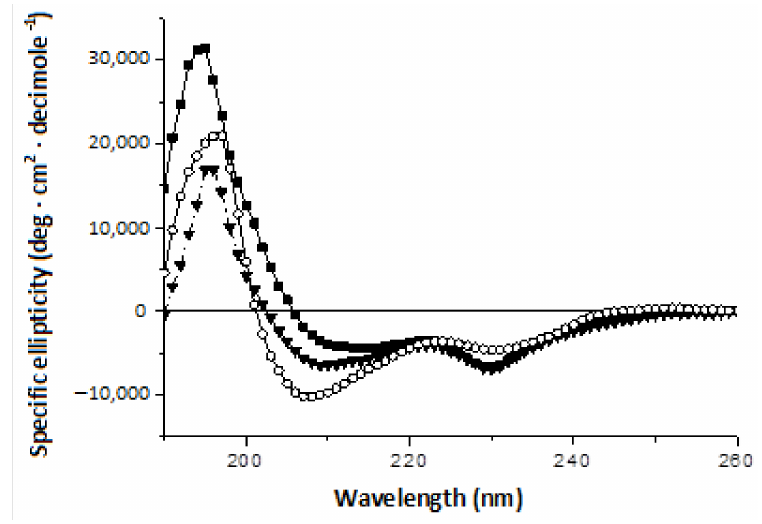
Figure 2. Circular dichroism (CD) spectral scans of binase ( (cid:4) ), balnase ( (cid:72) ) and balifase (